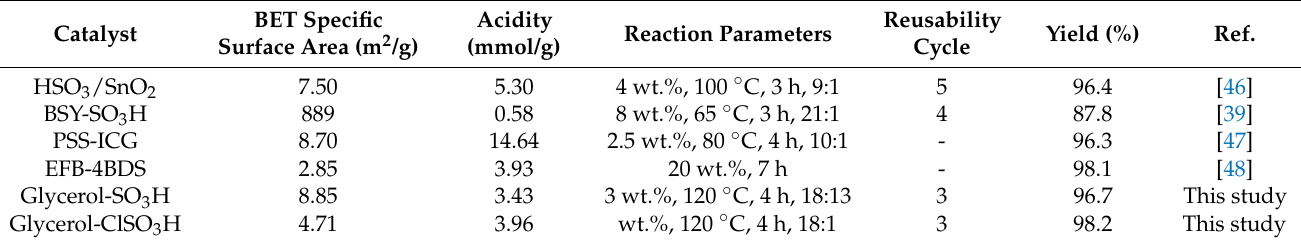
Table 2. Comparison analysis of sulfonated catalyst properties and catalytic esterification perfor-